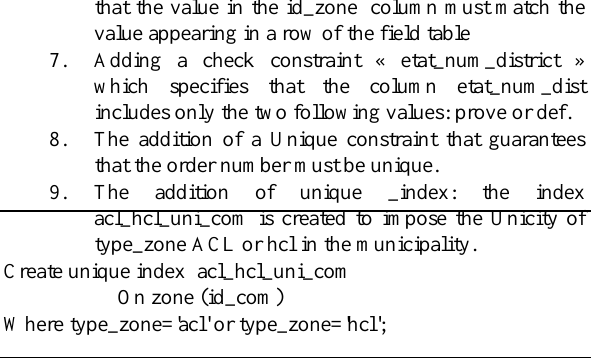
Figure 2. Representation of Unicity index .